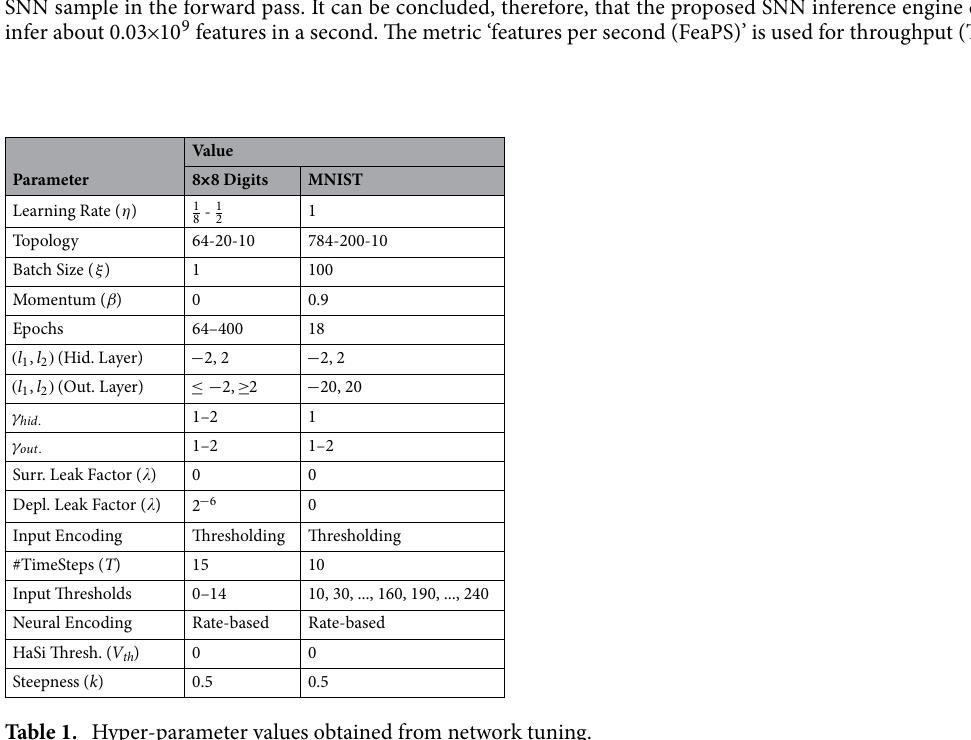
Table 1. Hyper-parameter values obtained from network tuning.